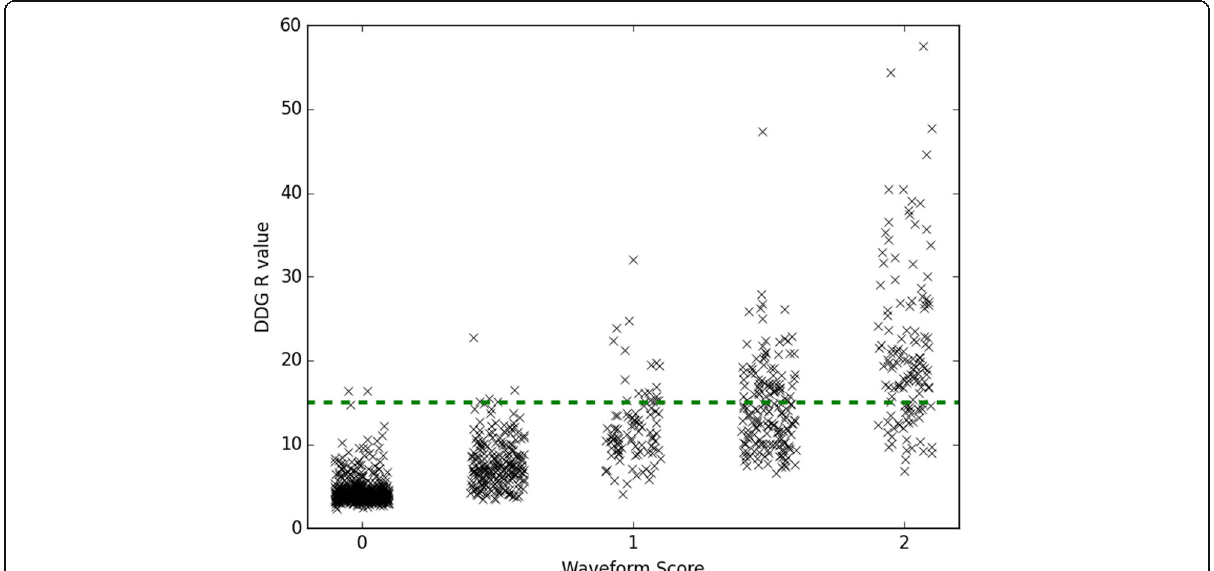
Fig. 2 Relationship between the algorithm ’ s figure of merit for the waveform (the R value) and the waveform score S as determined by two readers from visual inspection of the waveform. The horizontal dashed line shows a threshold, R = 15